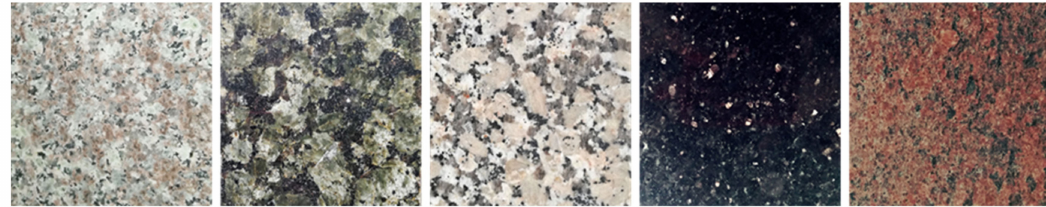
Figure 2. Successively: China (Royal Bronze), Finland (Baltic Green), Spain (Crema Julia), India (Star Galaxy), Sweden